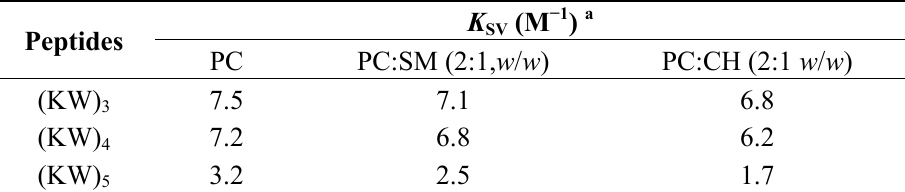
Table 1. K parameters of peptides at 2 μ M in PBS (pH 7.2) or in the presence of 200 μ SV